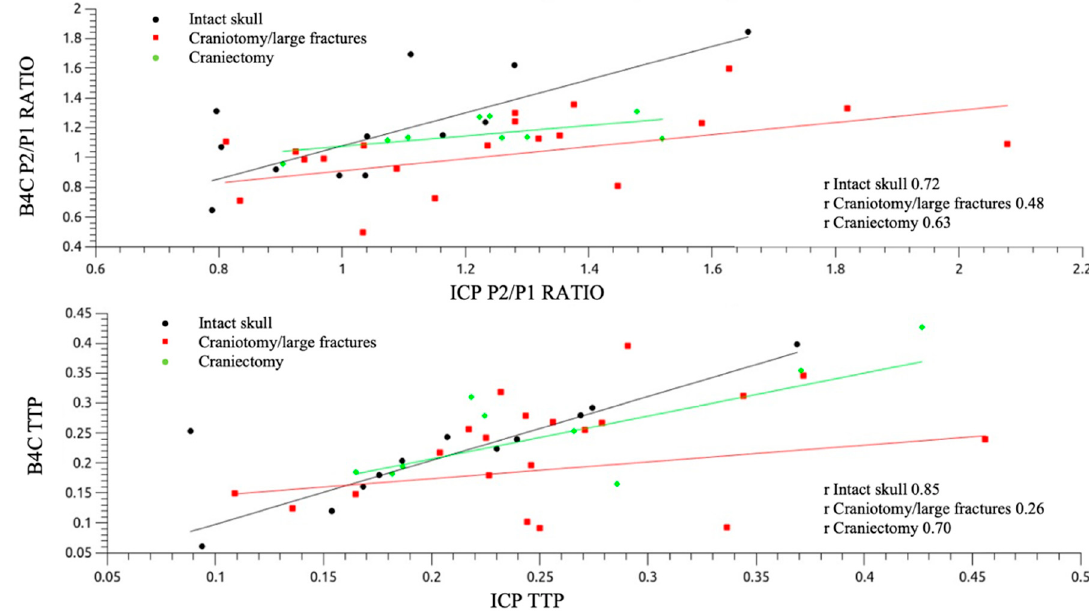
Figure 5. Pearson’s correlation analysis for P2/P1 ratio ( up ) and TTP ( down ) separated between groups according to cranial status.